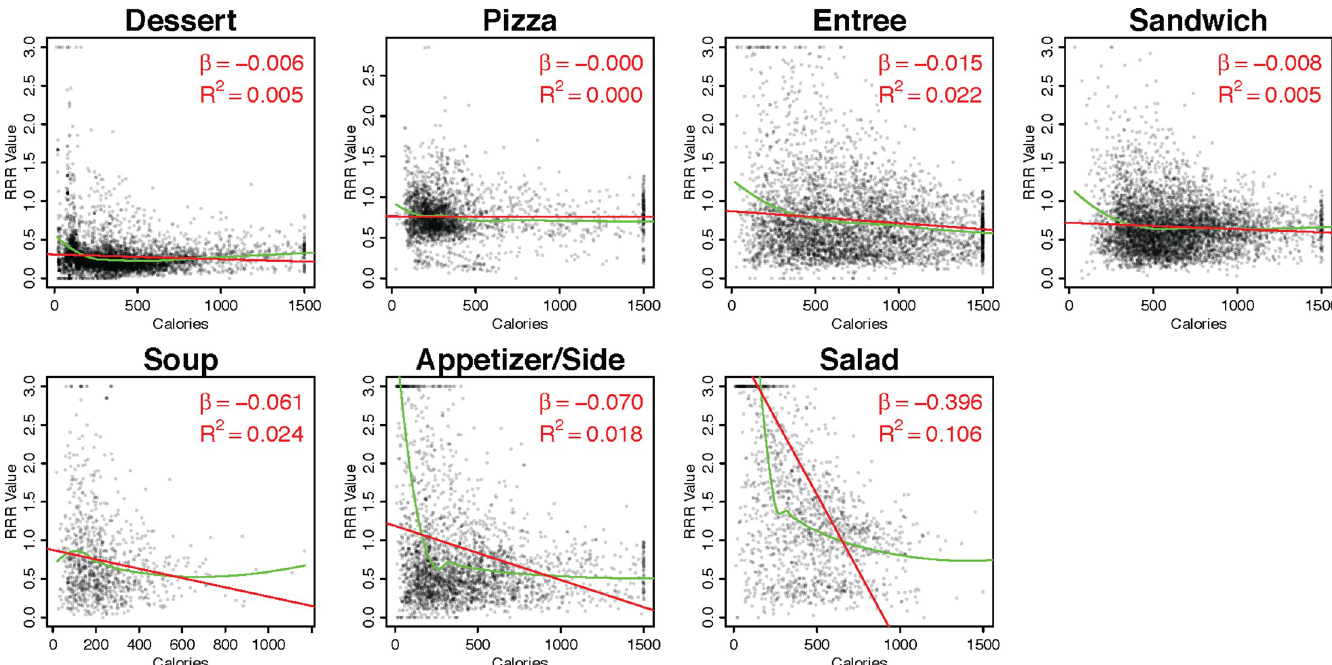
Fig 4. Correlation between calorie count and RRR value by main menu categories. Red lines depict the least squares fit and green lines depict a loess fit. β is the average increase in RRR associated with a 100 kcal. increase.